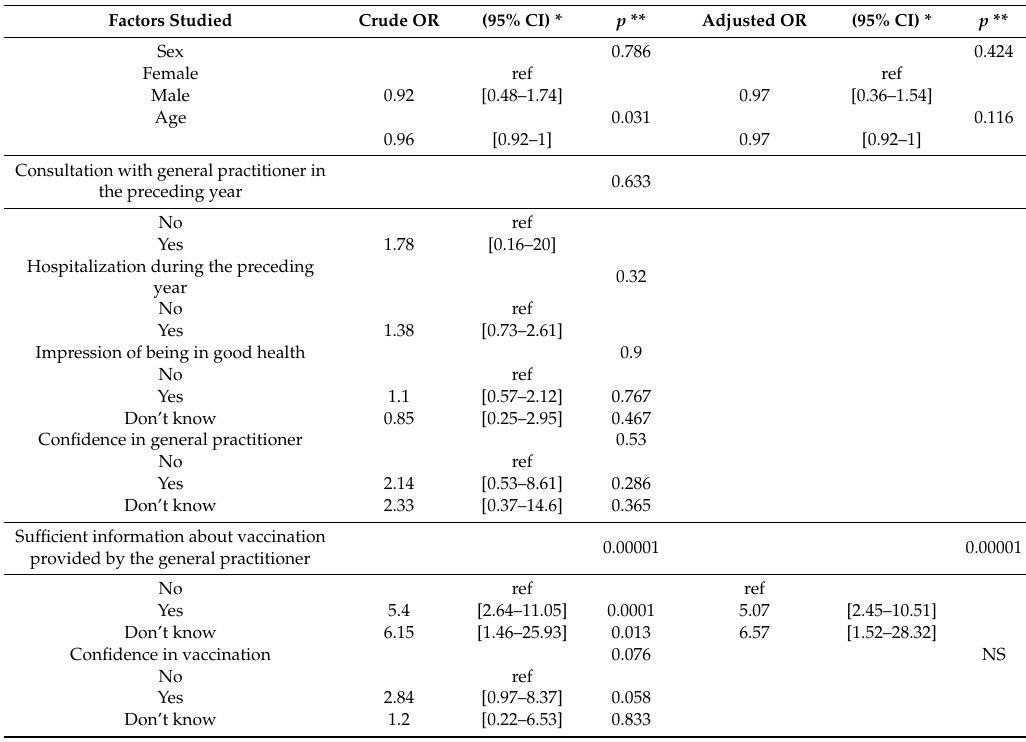
Table 4. Factors associated with up-to-date DT-IPV vaccination in the univariate and in the multivariable (final model) logistic regression